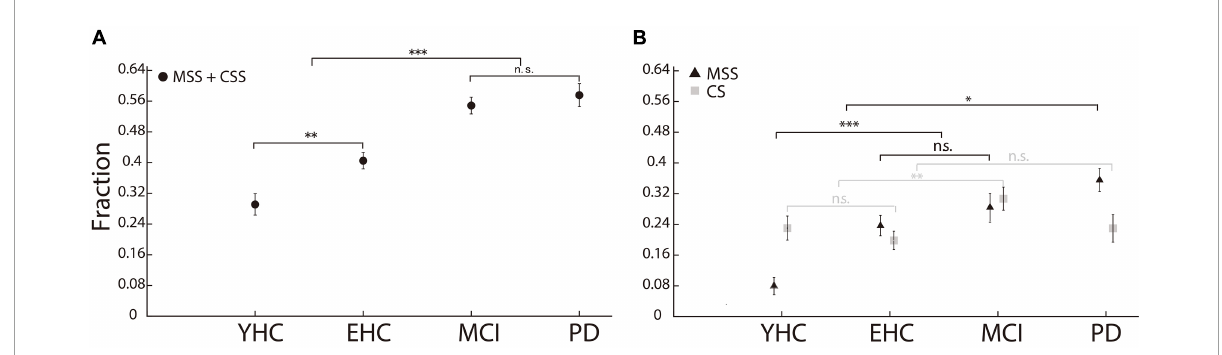
FIGURE2 Incidence of MSS and CS in the human study. (A) The incidence of MSS including CS. There was no significant difference in MSS incidence between PD and MCI. (B) The incidence of MSS and CS, respectively. The incidence of MSS in PD was significantly higher than that in YHC, EHC, and MCI participants. Error bars show the standard error of the mean; ∗ p < 0.05, ∗∗ p < 0.01, ∗∗∗ p < 0.001, n.s., no significant difference (Wilcoxon rank-sum